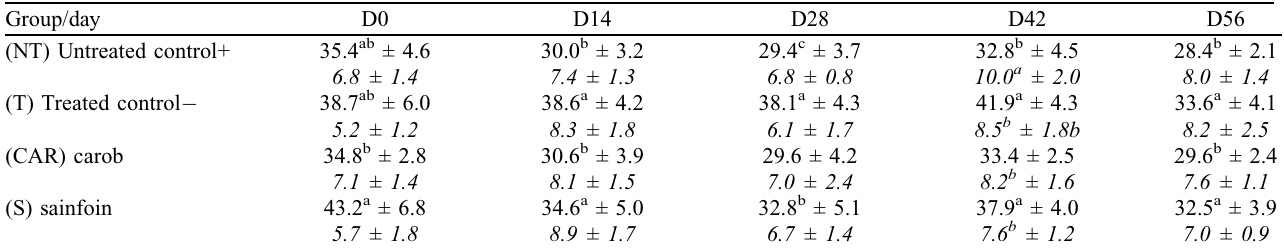
Table 2. Packed Cell Volume values (PCV) (normal style) and serum inorganic phosphate values ( italics ) on the different specific days of the trial (±SD). NT = positive control, T = treated, negative control, S = sainfoin fed group; CAR = Carob fed group. Different superscripts in the same column indicate significant